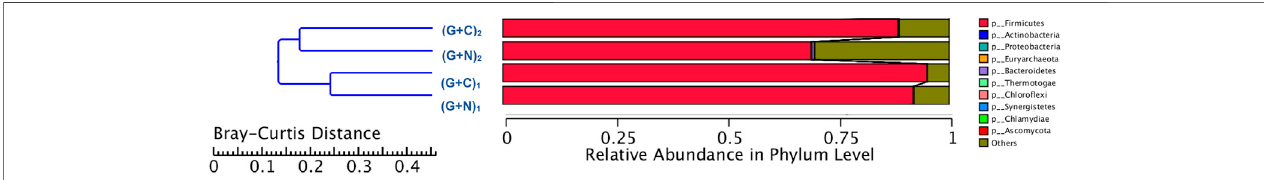
FIGURE8| ClusteringtreebasedonBray-CurtisdistanceofthemicrobialcommunityafterG+NandG+Cfermentationbyenrichedsludgefrom6 th transfer. “ (G+ N) 1 ” represents when glucose totally consumed using glucose as substrate and “ (G + N) 2 ” represents at the end of the incubation after CO was added. “ (G + C) 1 ” represents when glucose totally consumed and “ (G + C) 2 ” represents at the end of the incubation in glucose and CO co-fermentation.